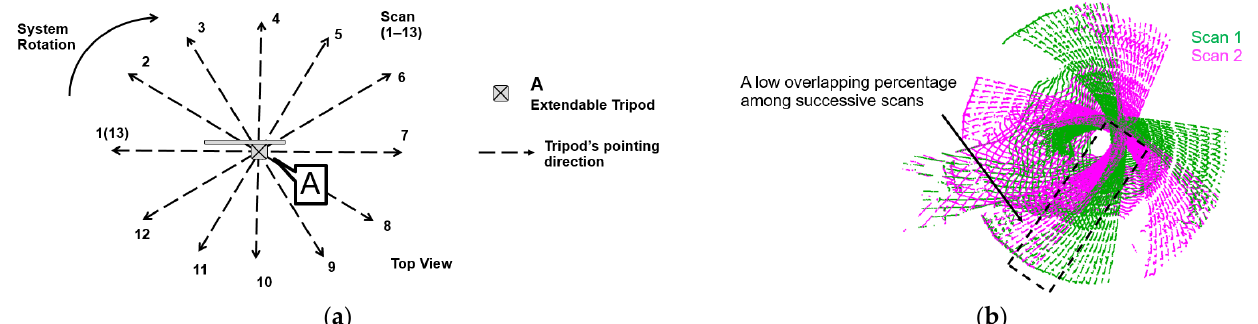
Figure 5. Data collection procedure for the SMART system and acquired LiDAR scans: ( a ) seven to thirteen scans are acquired at a given station and ( b ) limited overlap area between two successive scans.